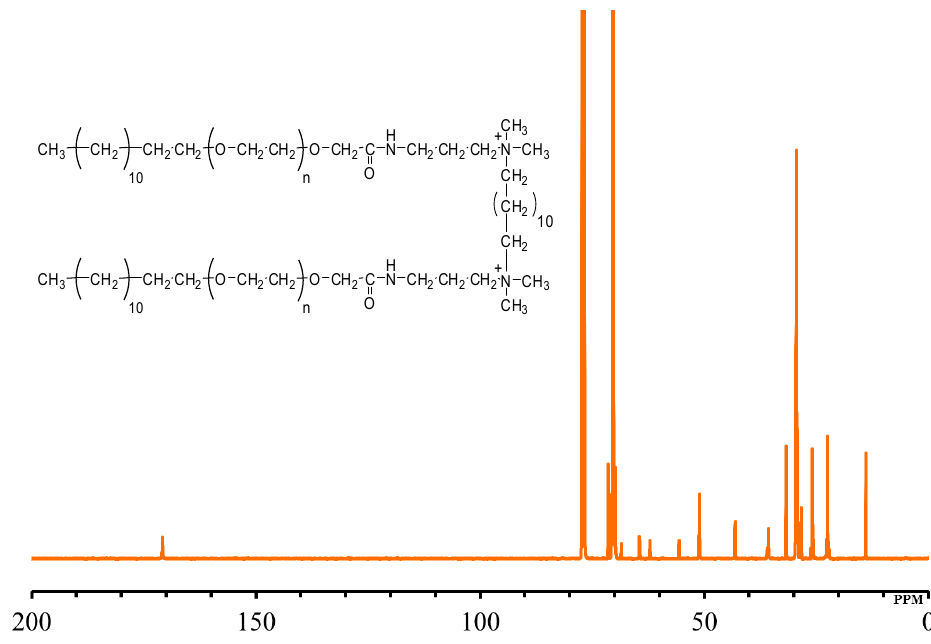
Figure 3. 13 C NMR of quaternary ammonium gemini surfactants (GS12). Table 2. 13 C NMR data describing the chemical shift values in GS12.